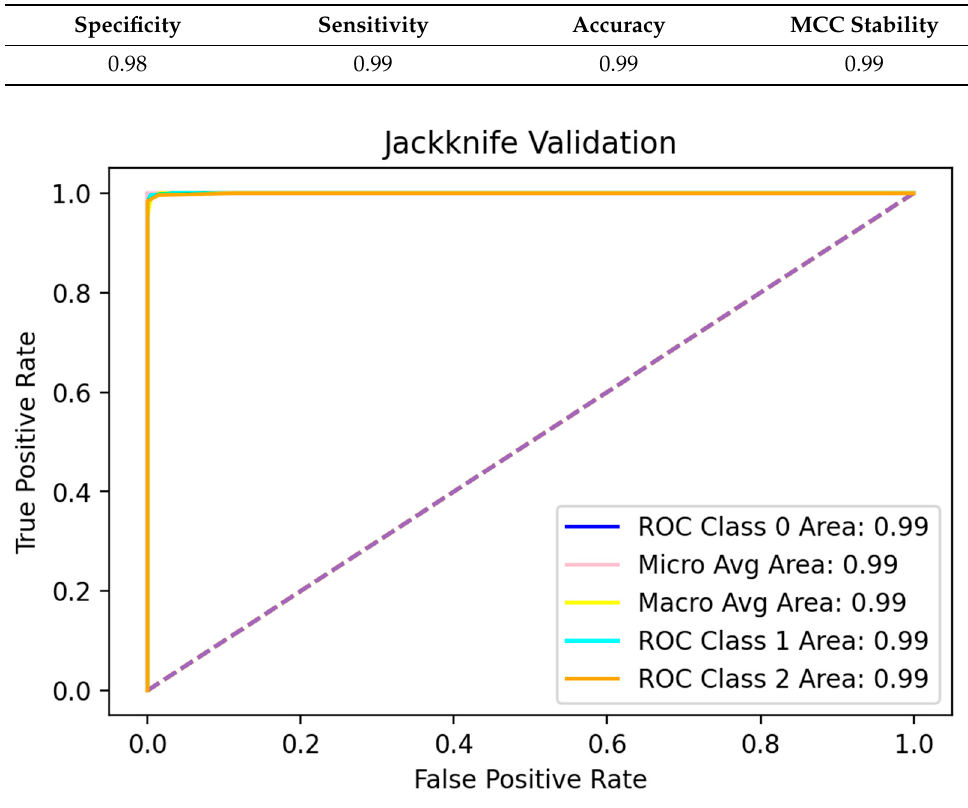
Table 4. Mean scores for Jackknife validation results.